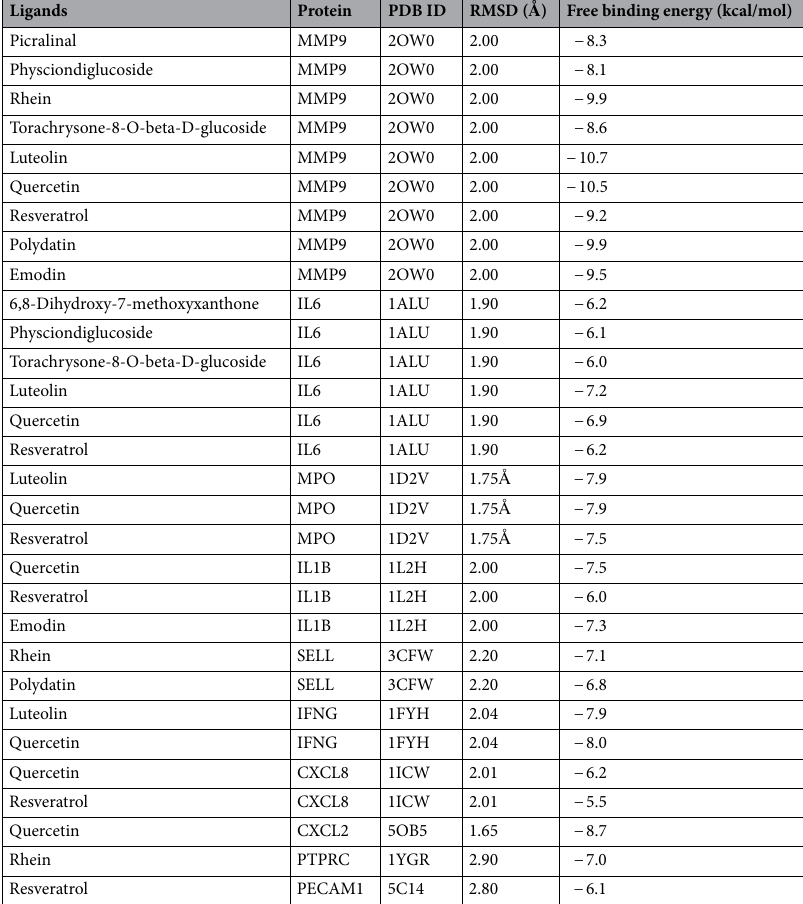
Table 3. Free binding energy of nine hub genes with their corresponding active